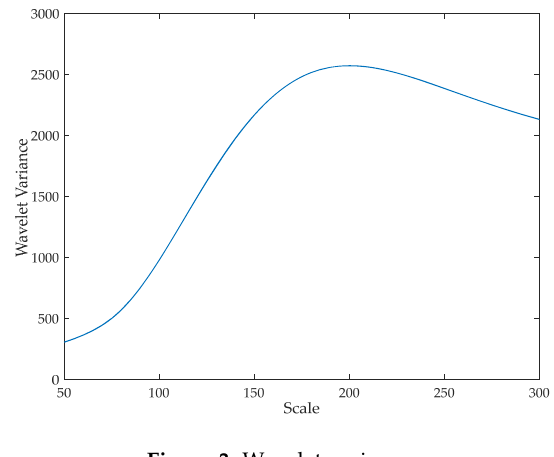
Figure 2. Wavelet coefficient of multiple scales of channel state information.